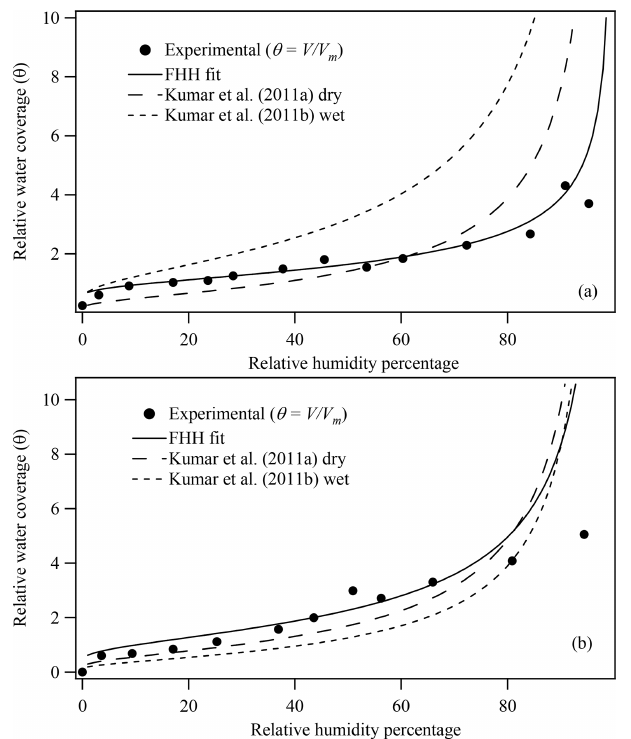
Figure 2. (a) Illite and (b) montmorillonite experimental water ad- sorption isotherms (Hatch et al., 2012) and associated FHH fit based on constrained FHH analysis, where the experimental θ was calcu- lated as V/V m and V m was determined from BET analysis of ad- sorption isotherms. FHH adsorption isotherms from FHH parame- ters determined from size-selected CCN measurements of aerosol generated using wet or dry aerosol generation methods are also shown (Kumar et al., 2011a).